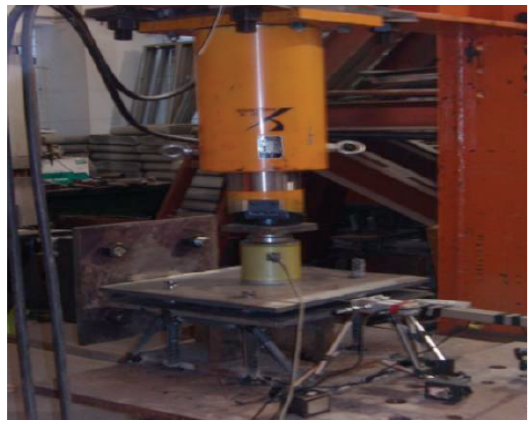
Figure 3. Experiment device system